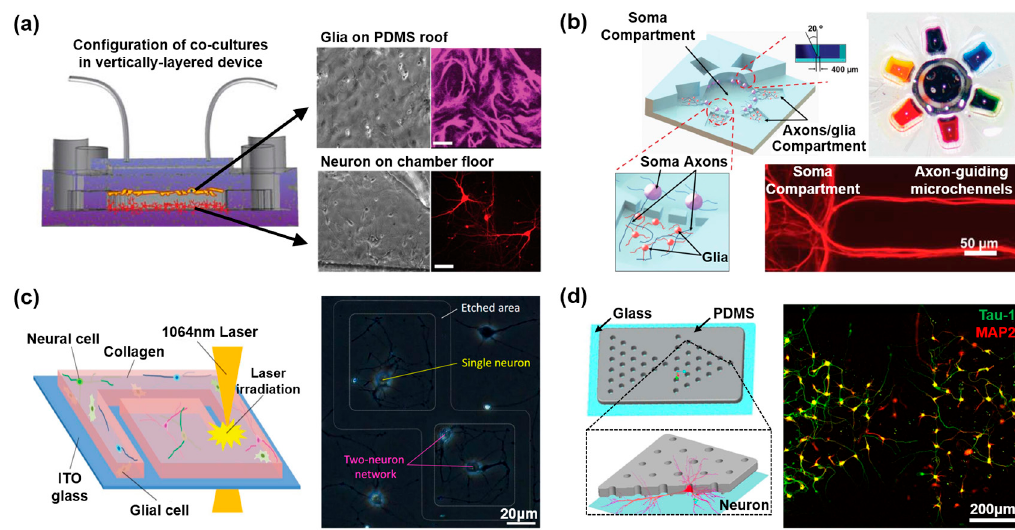
Figure 1. 2D and 3D neural networks on the microdevice. ( a ) Co-cultures of neurons and glia in the vertically-layered configuration. A monolayer of glial cells (polydimethylsiloxane (PDMS) roof) was immunostained with the glial-specific marker glial fibrillary acidic protein (GFAP). mCherry transfected neurons (chamber floor) were viewed in fluorescence. Reproduced with permission [30]. Copyright 2013, Royal Society of Chemistry; ( b ) 3D illustration and images of the multi-compartment neuron–glia co-culture microsystem capable of carrying out multiple localized axon treatments in parallel axons from neuronal soma, for localized axon–glia interaction studies. Reproduced with permission [26]. Copyright 2012, Royal Society of Chemistry; ( c ) Control of culturing area and the number of neurons using collagen gel photothermal etching to monitor the synaptogenesis. Reproduced with permission [28]. Copyright 2013, Royal Society of Chemistry; ( d ) The uniformly aligned neural network was generated with the patterned hole array platform for interrogating neural